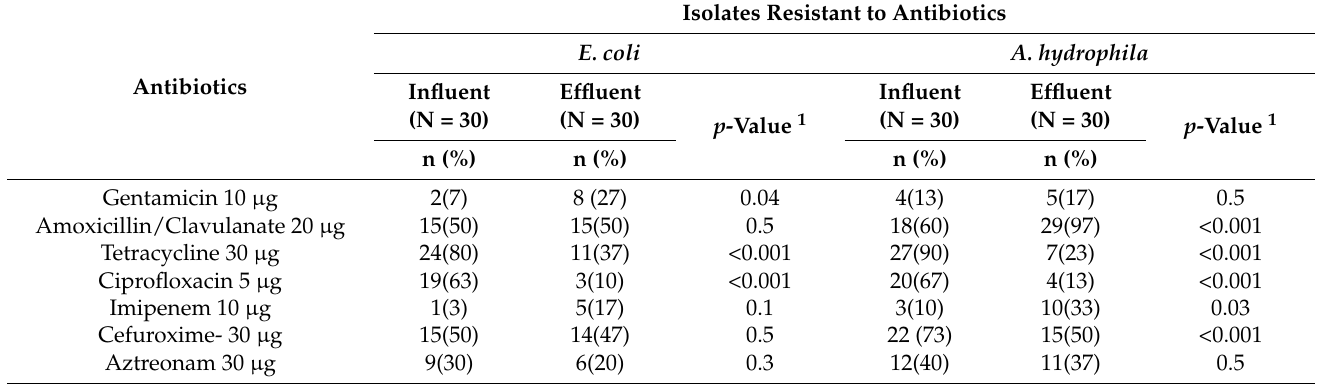
Table 2. Antibiotic resistance of E. coli and A. hydrophila isolates in influent and effluent wastewater from the Legon Sewage Treatment Plant, Accra, Ghana (January to June 2018).